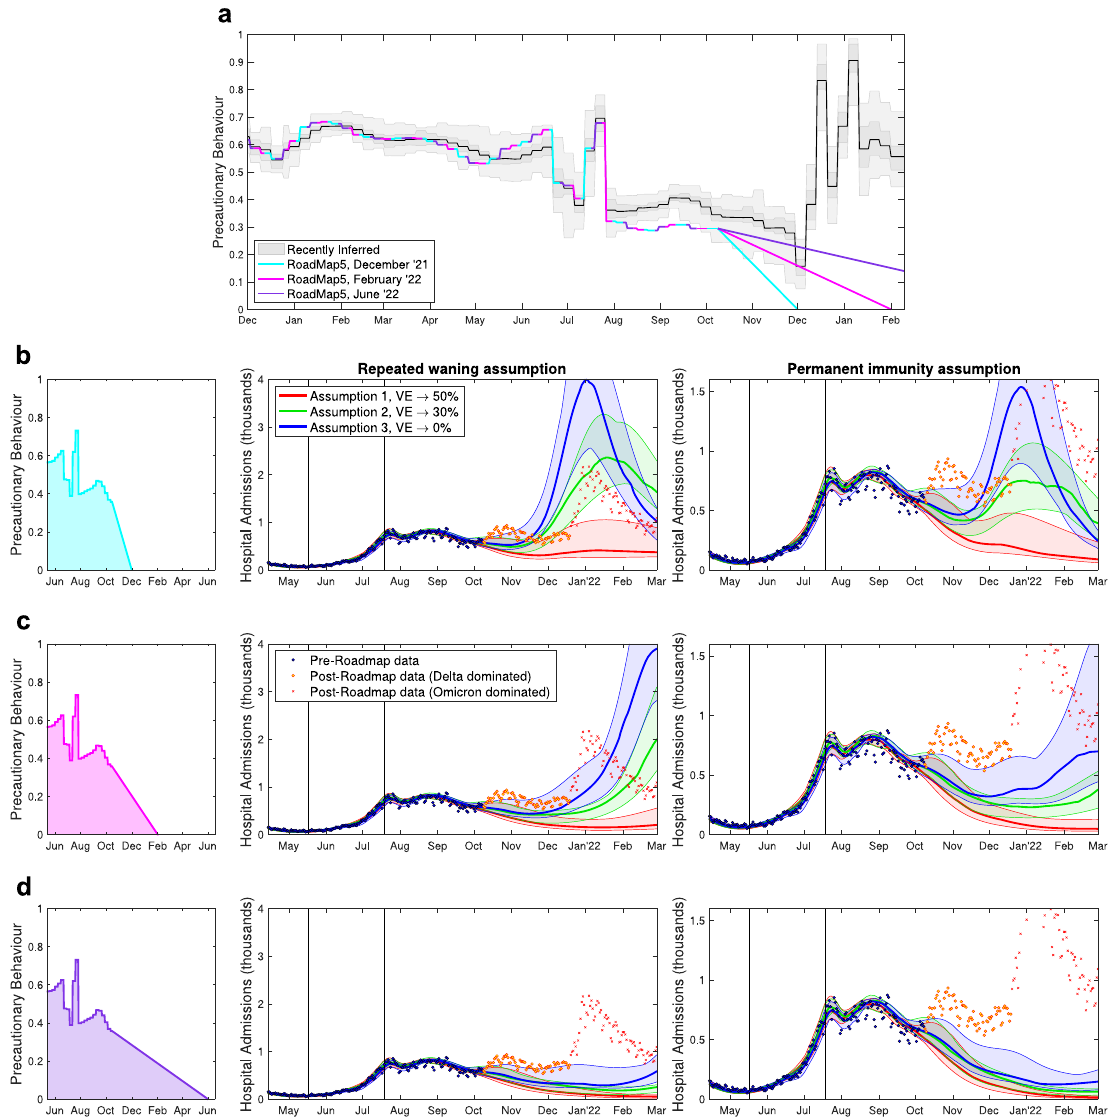
Fig.8|HospitaladmissionprojectionsfromRoadmap5Fig.5 18 . Scenarioscover behaviour (grey, showing mean, 50% and 95% credible intervals) together with the three different assumptions (cyan, pink and purple) about the return to pre-